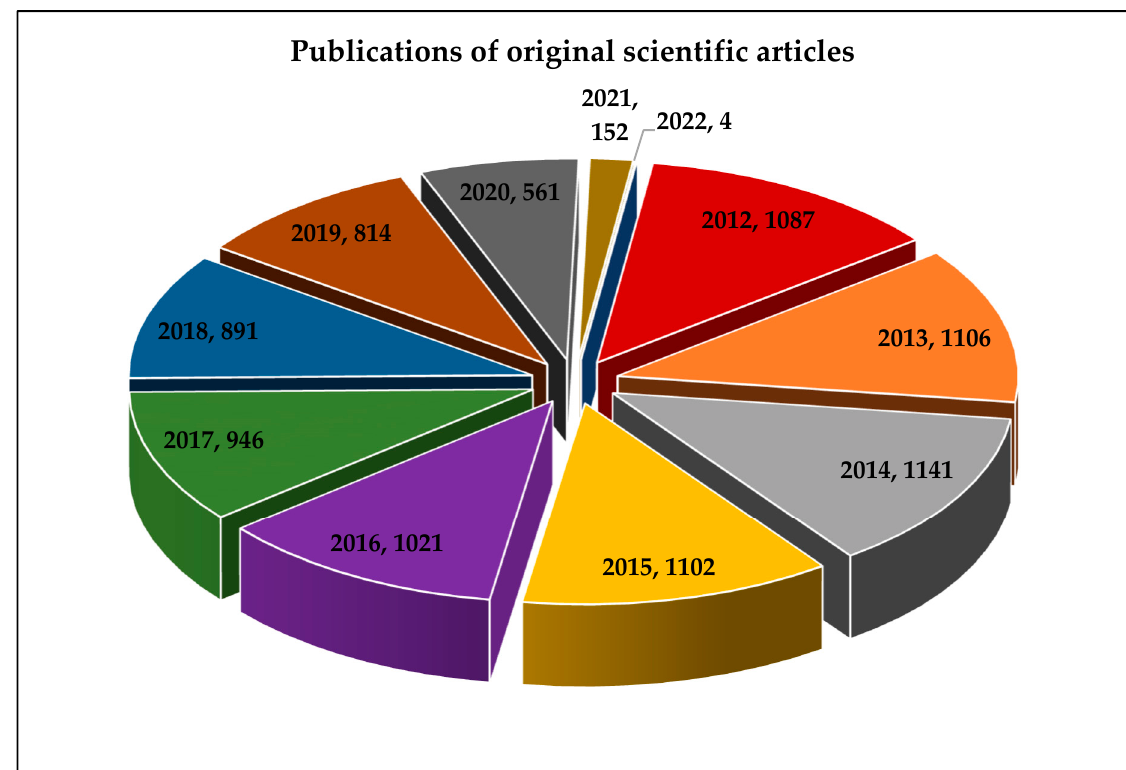
Figure 2. Published original scientific articles under the keywords “nanoantioxidants”, “antioxidant nanomaterials”, and “nanomaterials and antioxidant activity” (based on a SciFinder search; duplicates removed, November 2021).